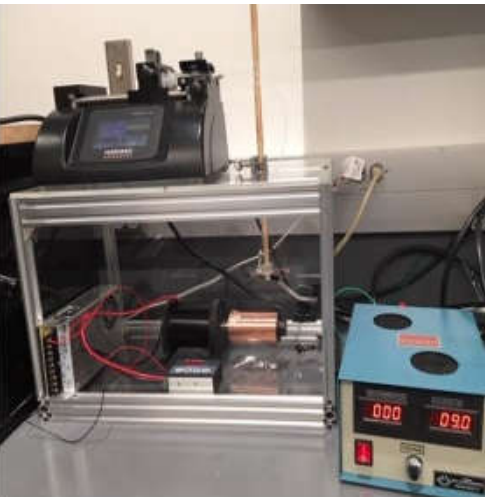
Figure 2. Electrospun fabrication unit used to produce the nanofiber dressing.